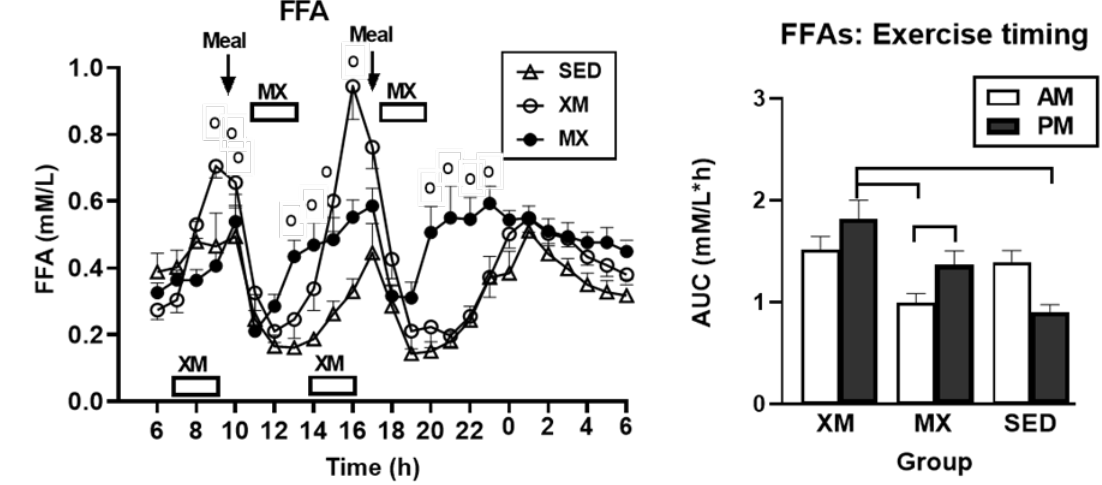
Figure 2. Exercise- and meal-timing effects on the concentrations of FFAs and their AUCs. Circle superscripts identify time slices when group concentration differences were significantly different ( left panel). AUCs represent 2 h of exercise and one post-exercise hour. Afternoon XM AUCs were significantly higher than morning MX and afternoon SED AUCs. Within the MX trial, PM AUC was higher than the AM AUC ( right panel). Brackets identify groups with significant between- and within-group AUC differences ( right panel). XM = exercise before meals, MX = exercise after meals, SED = sedentary